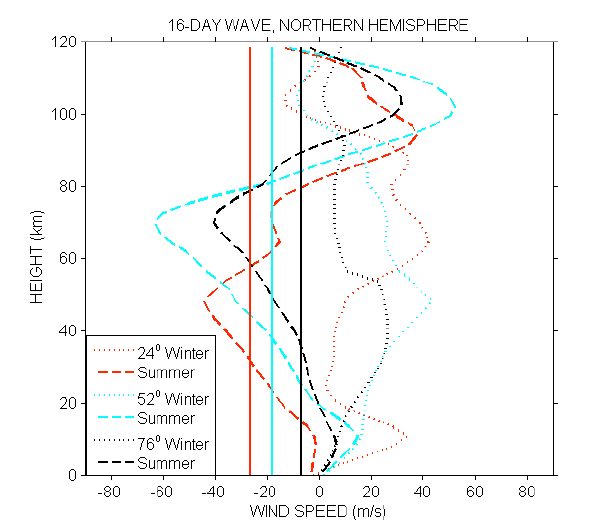
Fig. 2. URAP winds for latitudes of 24 ◦ , 52 ◦ and 76 ◦ N for both winter (January) and summer (July). Also plotted are the zonal phase speeds of the 16-day wave for these